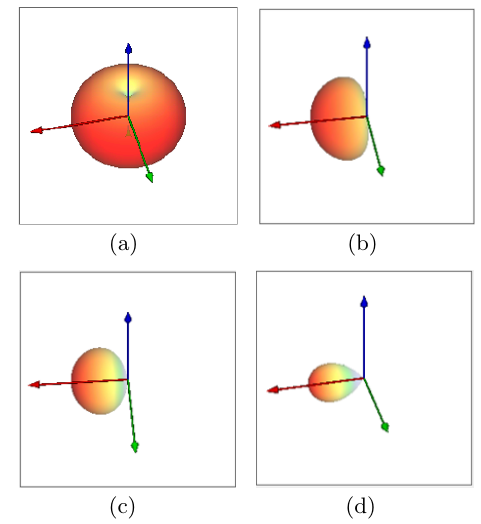
Figure 3: 3D radiation patterns of (a) dipole, (b) 90 ◦ beam antenna, (c) 60 ◦ beam antenna and (d) 30 ◦ beam